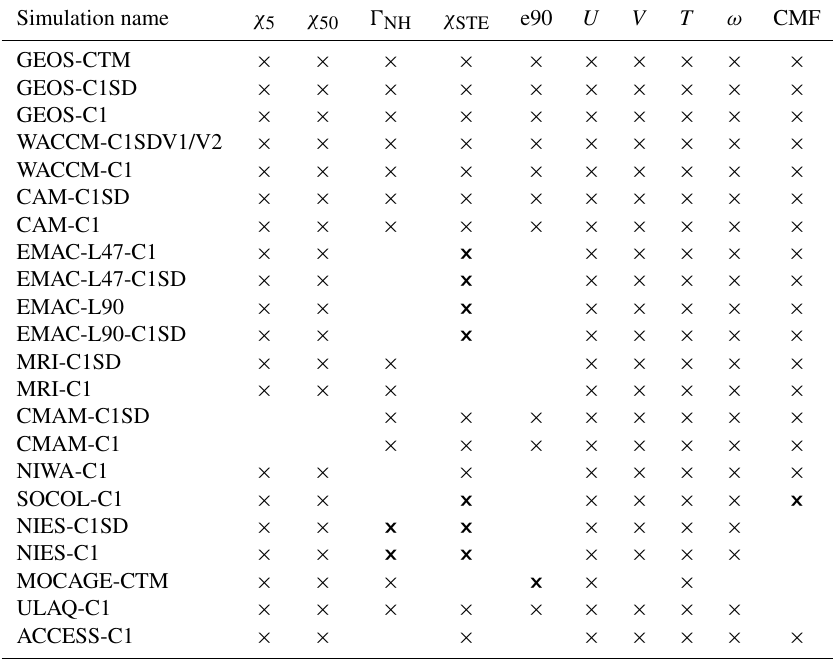
Table 3. List of the model simulations for which the idealized tracers ( χ 5 , χ 50 , (cid:48) NH , χ STE and e90) and dynamical fields ( U , V , ω , T and parameterized convective mass fluxes – CMFs) were available. Thin crosses denote fields that output in simulations. Thick crosses denote fields that were output, but were not correctly